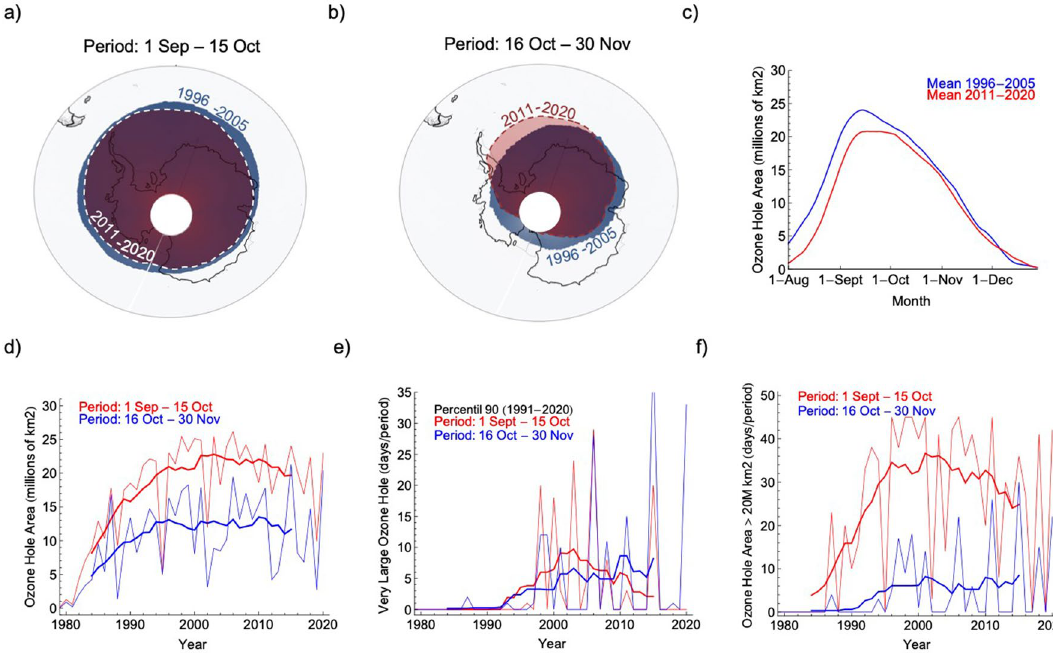
Figure 4. Long-lasting and large ozone holes, that often bring ozone-depleted air over the northern most part of the continent in late spring, have been occurring at about the same frequency during the last two decades. ( a ) Changes from 1996–2005 to 2011–2020 in the ozone hole area averaged from 1 September to 15 October. ( b ) Changes from 1996–2005 to 2011–2020 in the ozone hole area averaged from 16 October to 30 November. ( c ) Daily estimates of the ozone hole area averaged over two periods: 1996–2005 (blue line) and 2011–2020 (red line). ( d ) Progress of ozone hole area averaged from 1 September to 15 October (red line) and from 16 October to 30 November (blue line). ( e ) Number of days with a very large ozone hole area (defined according to the 90th percentile) counted over two periods: from 1 September to 15 October (red line) and from 16 October to 30 November (blue line). ( f ) Number of days with an ozone hole area larger than 20 million km 2 counted over two periods: from 1 September to 15 October (red line) and from 16 October to 30 November (blue line). Bold lines in plots ( d – f ) show 11-year centered moving averages. In plots ( a , b ) the ozone hole was estimated considering the area within which, on average over the decades either 1996–2005 or 2011–2020, daily TOC values were lower than 220 Dobson units (DU) on twenty or more days per period. Data from the TOMS instrument on the Earth Probe satellite and from the OMI instrument onboard the Aura satellite were used in plots ( a , b ). Data produced by the Laboratory for Atmospheres at NASA’s Goddard Space Flight Center were used in plots ( c – f ). The plots were generated using Python’s Matplotlib library 71